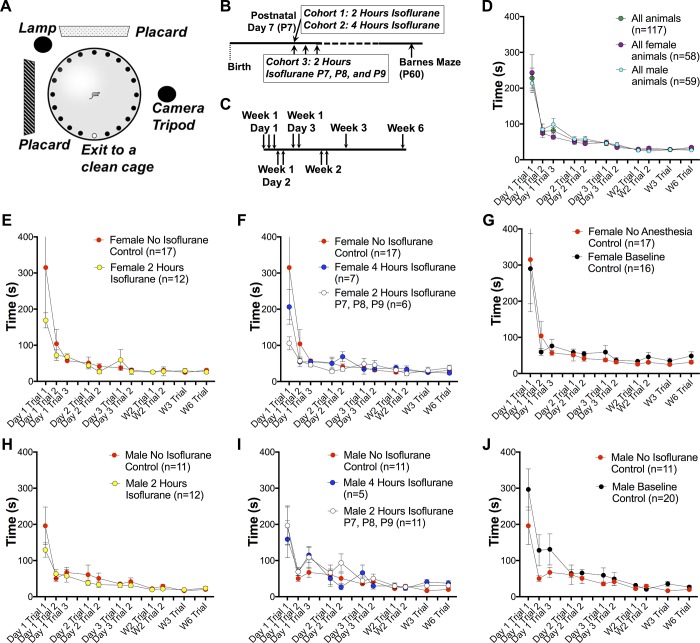
Cognitive outcomes in anesthesia exposed P7 neonatal mice.(A) Barnes maze setup and Barnes maze testing paradigm (see Methods for details and specifications). (B) Timeline of anesthesia treatment and Barnes maze assessment and anesthesia paradigms explored in this study. (C) Barnes maze paradigm utilized in this study. (D) Composite data from all mice from all treatment cohorts. (E, H) Assessment of female (E) and male (H) animals treated with 2 hours of anesthesia with 1.5% isoflurane mice compared to mock treated controls (see Methods). (F, I) Assessment of female (F) and male (I) animals treated with 4 hours of anesthesia with 1.5% isoflurane or treated 2 hours of 1.5% isoflurane daily for three days compared to mock treated controls (see Methods). (G, J) Assessment of female (G) and male (J) animals given mock treatment compared to animals receiving no handling (aside from routine animal maintenance) prior to behavioral assessment (see Methods). Animal numbers are listed in every panel; in all panels data points represent the mean, error bars represent SEM. Row by row comparisons by pairwise t-tests yielded no significant differences (by p-value <0.05 cutoff) at any time point in any paradigm, even when no multiple testing correction was applied and thus the least stringent criteria for statistical significance used.